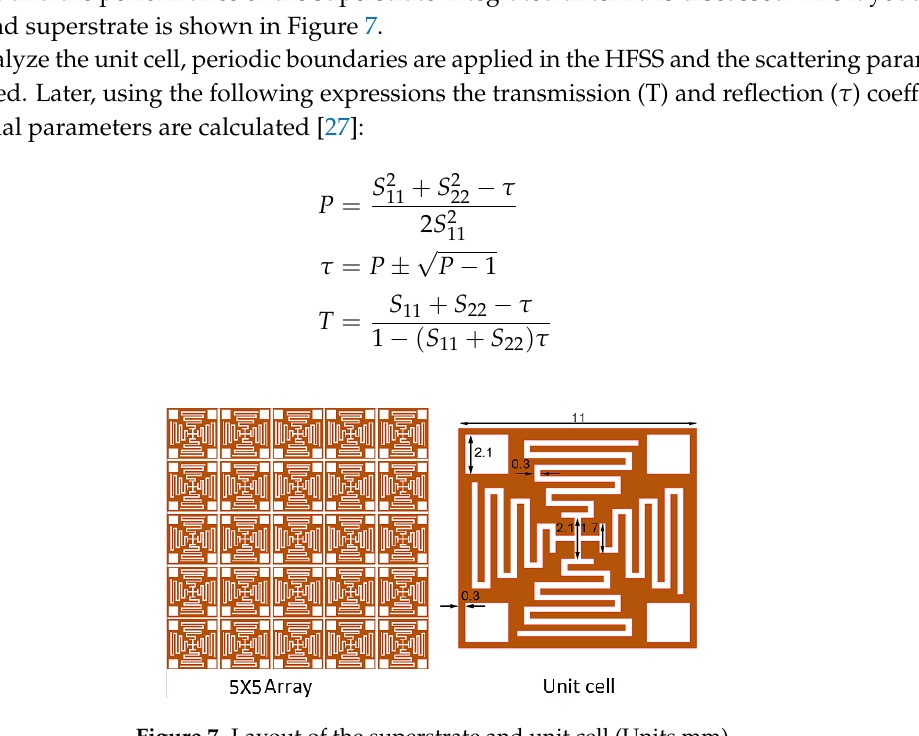
Figure 7. Layout of the superstrate and unit cell (Units mm).